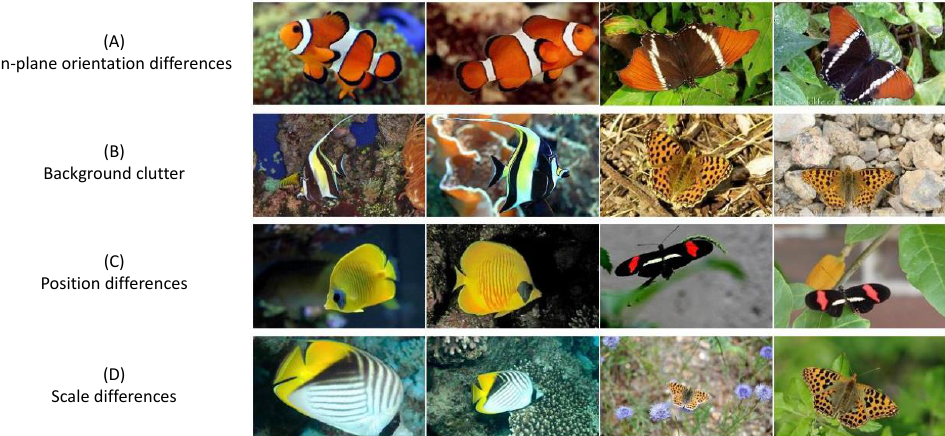
Figure 2. Common image variations found in butterflies and reef fish images showing different background clutters, scales, and